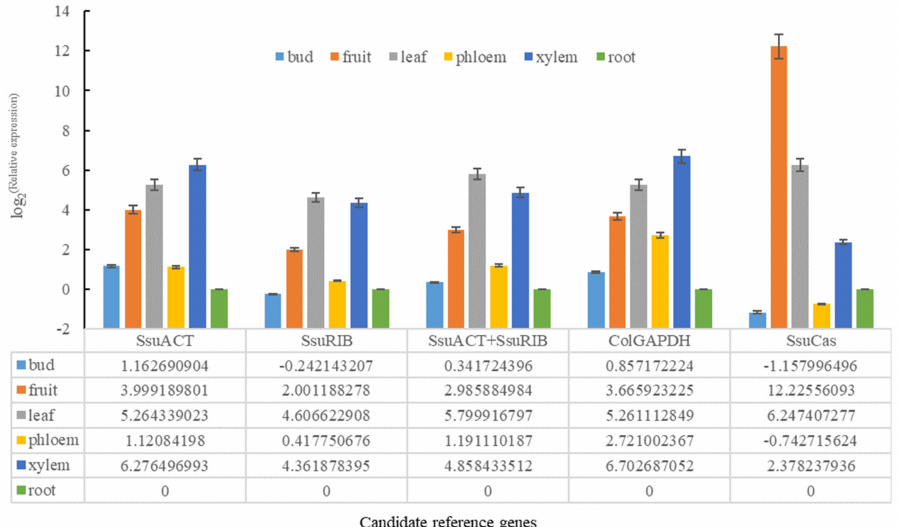
Figure 4. Relative expression of the SsuSND1 gene using various different reference genes for normalization in different tissues of S. superba